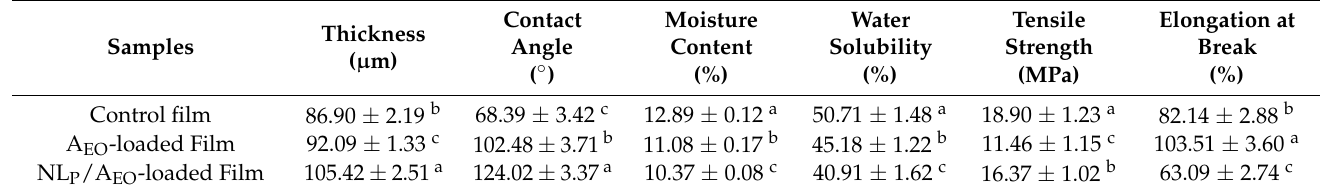
Table 3. Effect of free and nanoliposomal A EO on physical and mechanical properties of Salep mucilage bionanocomposite